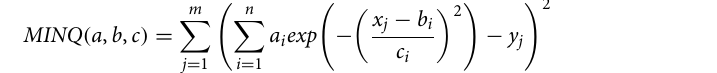
Table 3. Parameters determined by Gauss multi-peaks method with 95% confidence bounds (C 2 –D 2 ).